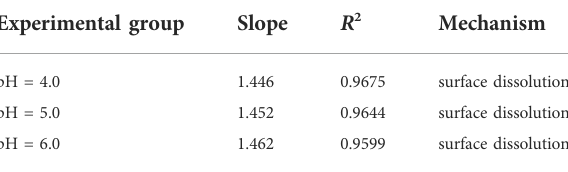
TABLE 6 Release mechanism of uranium in tailings under different pH rainfall leaching. Experimental group Slope R 2